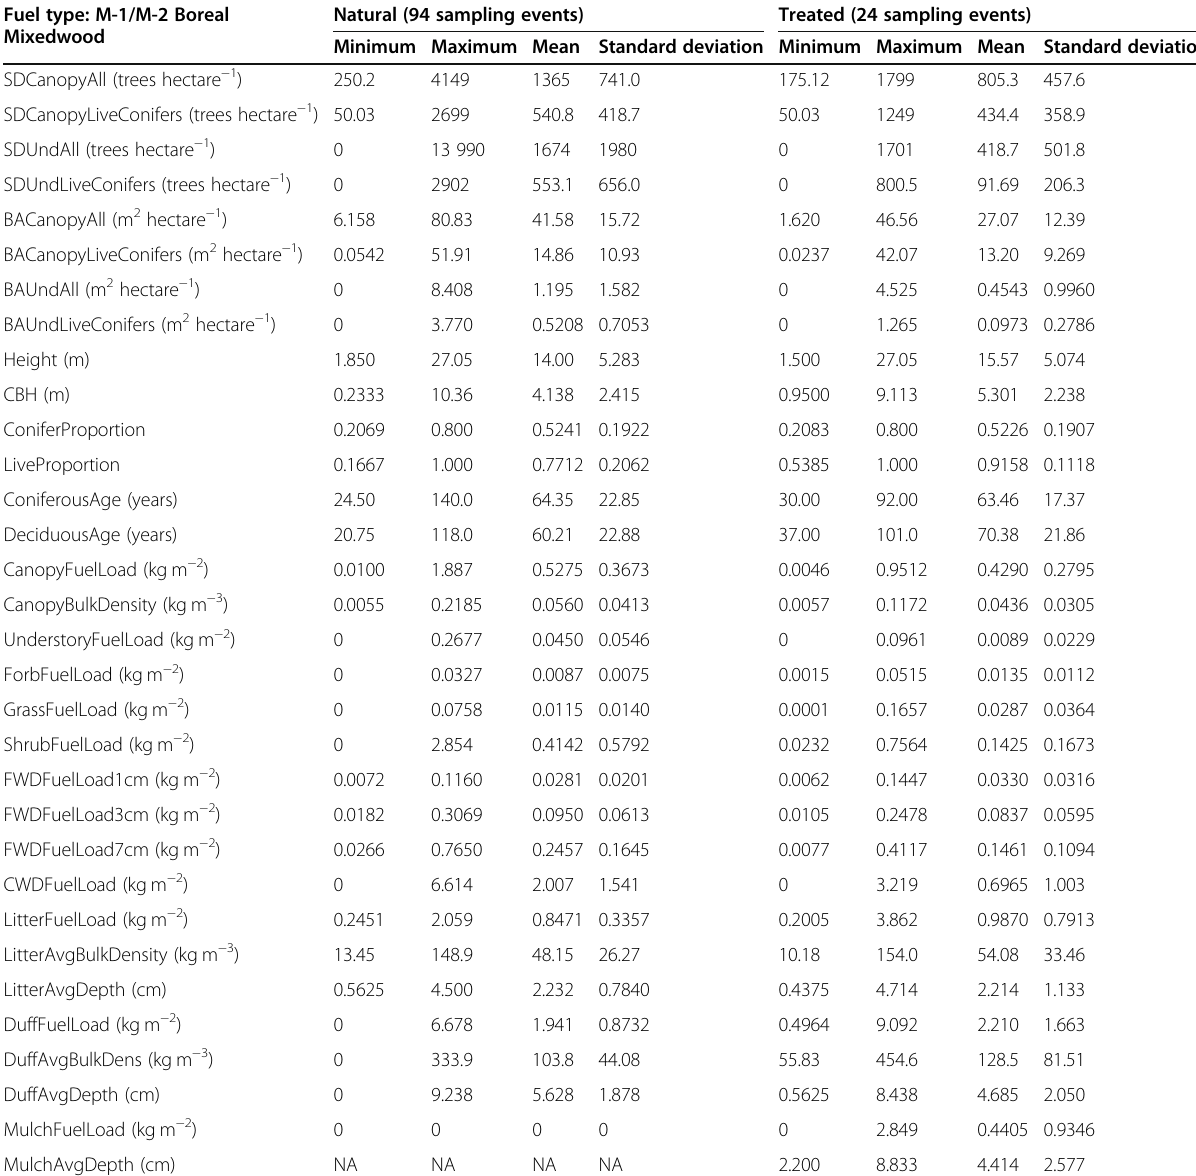
Table 4 Summary tables describing the minimum, maximum, mean, and standard deviation for several stand level features for each fuel type and treatment status by fuel type: M-1/M-2 Boreal Mixedwood. It should be noted that the number of sampling events for each category is not necessarily the number of sampling events contributing to the computation. For example, a sampling event might not have any deciduous trees and therefore would not contribute to the computation of statistics about the age of deciduous trees. A value of NA indicates that there were zero — or possibly one in the case of standard deviation — sampling events contributing to the computation. Values were rounded to four significant figures, up to four decimal